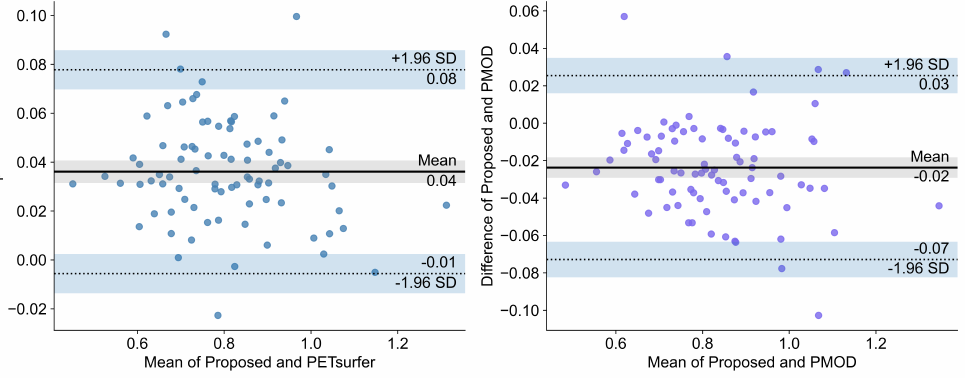
Figure 3. Bland–Altman plot of the proposed method, PETSurfer, and PMOD for the global region of amyloidosis-positive